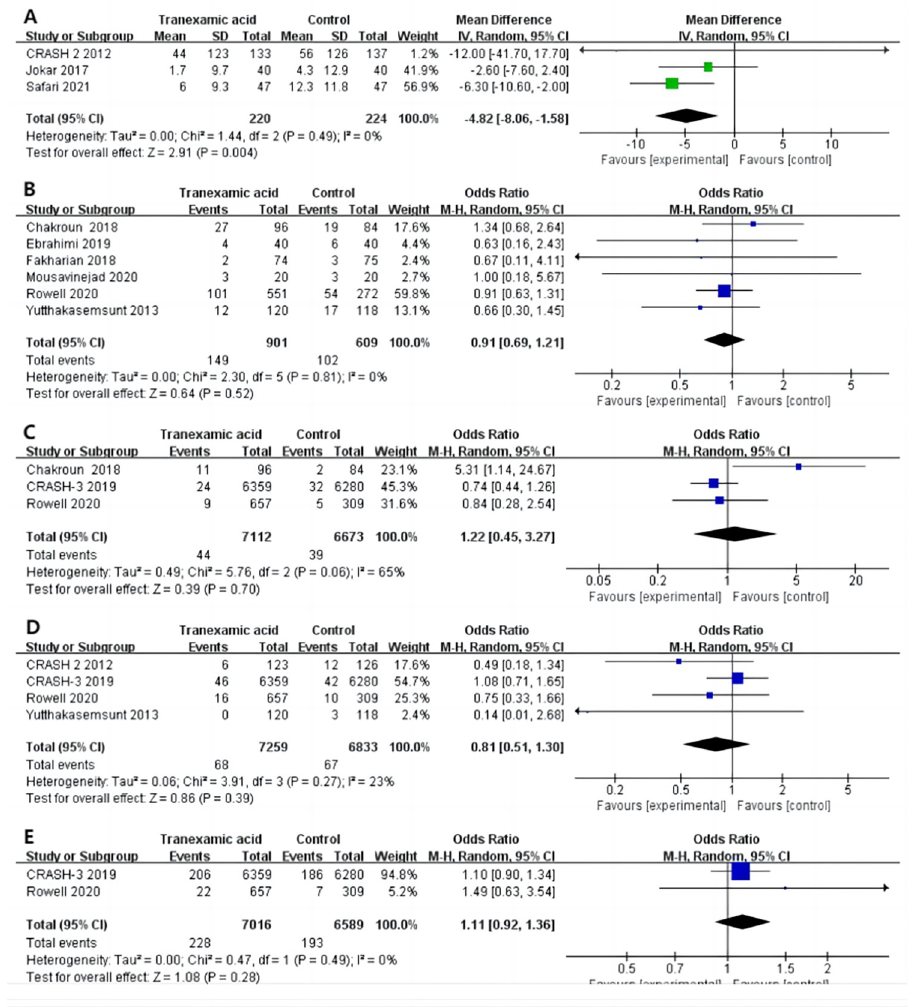
Fig 3. Forest plot of the effect of tranexamic acid on Hematoma growth (A), Mortality (B), PE (C), IS or TIA (D), and Seizures (E) in patients with